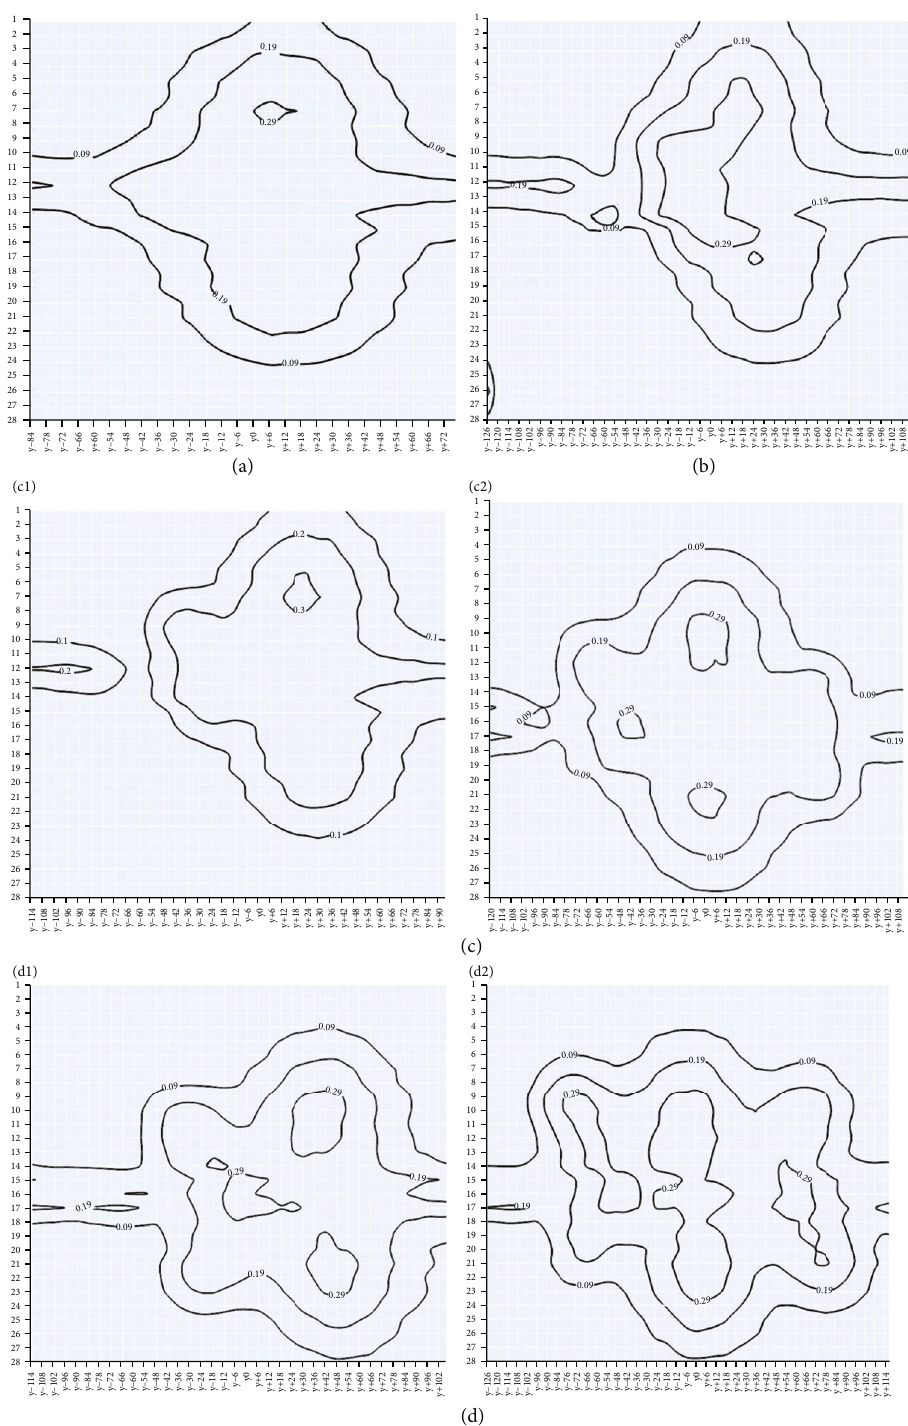
Figure 17: Loss distributions in the form of cp isolines at SD = 9 : 6 obtained from present wind tunnel measurements. (a) 90new3 single. (b) 90new3-30, CW = 2 : 12 . (c1) 90new3-30 dual. (c2) 30-90new3-30 triple layouts with CW = 2 : 4 . (d1) 90new3-60 dual. (d2) 60-90new3-60 triple layouts with CW = 2 : 6